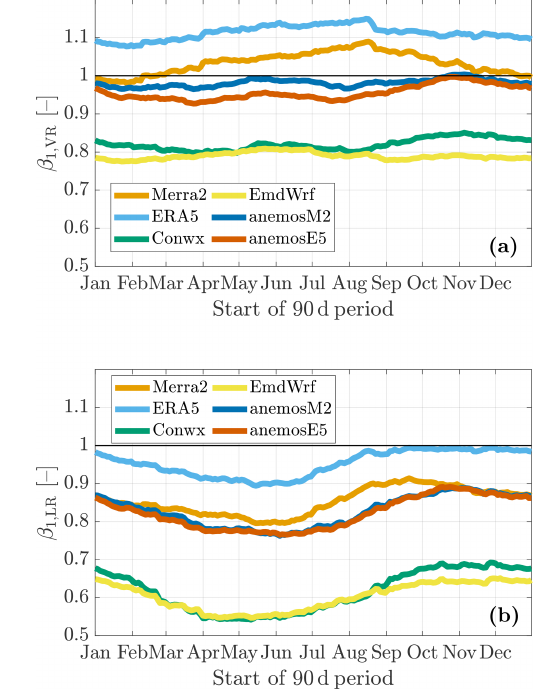
Figure 4. Temporal variations of regression parameter (a) β 1 , VR for the variance ratio and (b) β 1 , LR for the linear regression with residuals methods. The respective values were determined using a 90d sliding window and arithmetically averaged over all sites.